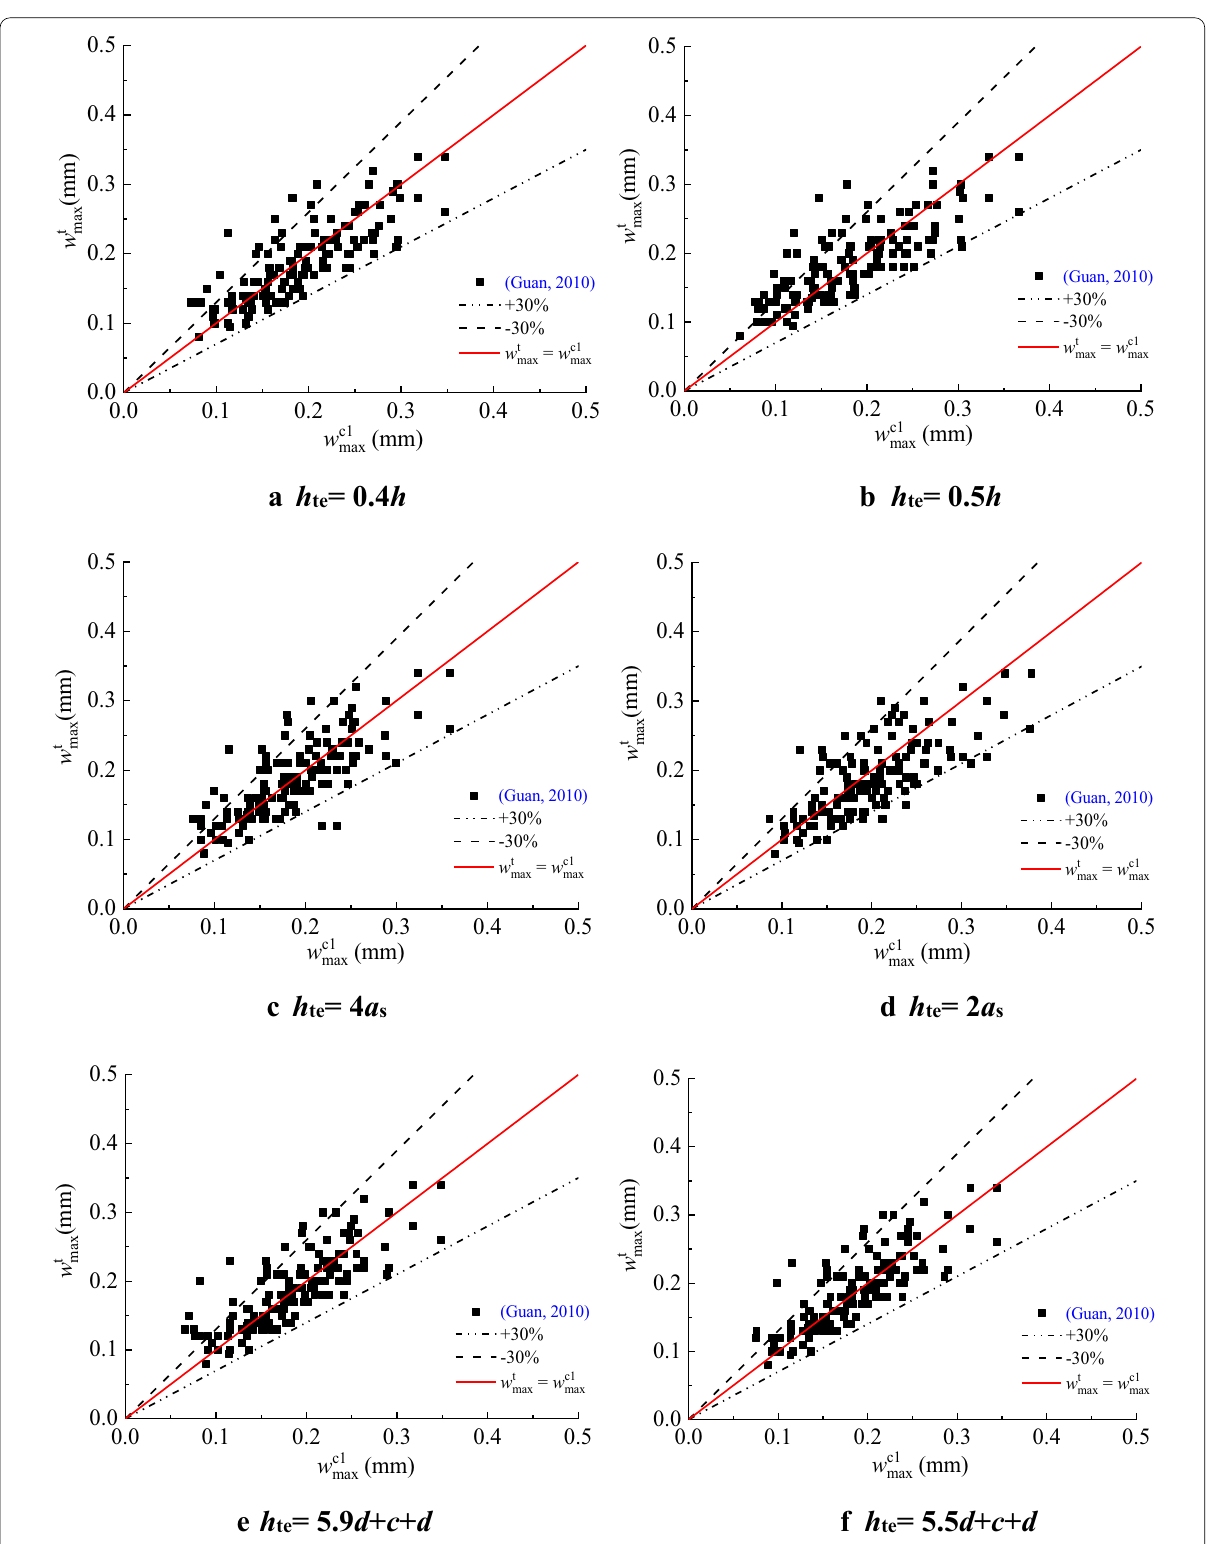
Fig. 15 Comparison of experimental w t max from RC beams with 335 MPa steel bars with calculated w c1 max by the proposed